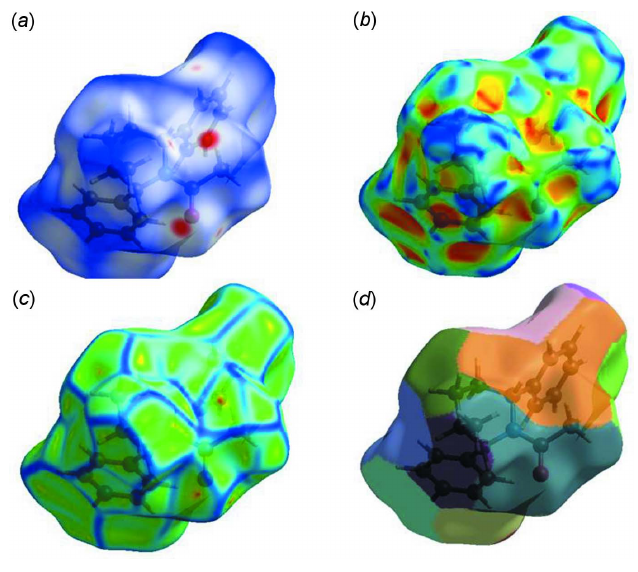
Figure 6 Hirshfeld surfaces mapped over ( a ) d norm , ( b ) shape-index, ( c ) curvedness and ( d ) fragment longer contacts are indicated as red and blue spots, respec- tively, on the Hirshfeld surfaces, and contacts with distances approximately equal to the sum of the van der Waals radii are represented as white spots. The most important red spots on the d surface represent C—H (cid:3) (cid:3) (cid:3) O interactions. norm The HS mapped over curvedness and shape-index, intro- duced by Koendrink (Koenderink, 1990; Koenderink & van